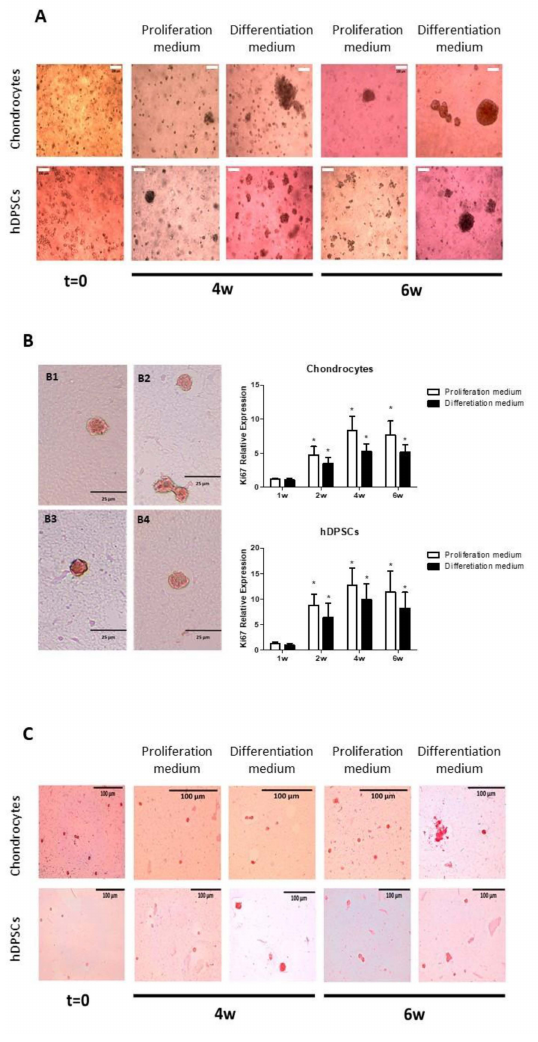
Figure 4. Encapsulation of cultured cells in alginate-agarose hydrogels. Human primary chondro- cytes or hDPSCs were cultured in hydrogels containing 3% alginate and 1% agarose with proliferation or differentiation medium, for up to 6 weeks at a density of 2 × 10 6 cells/mL. ( A ) Cell distribution was evaluated by phase contrast microscopy. ( B ) Cell proliferation was estimated by ki67 expression detected by immunohistochemistry (panels B1-4) and determined by real-time RT-PCR. Ki67-positive chondrocytes are shown in subpanel B1 (in proliferation medium), B2 (in differentiation medium), and ki67-positive hDPSC in B3 (in proliferation medium) and B4 (in differentiation medium), all cultured for 6 weeks. Graphs represent the expression of the Ki67 gene; data represent means ± SD of n = 3, * p < 0.05 compared to cells cultured for 1 week. ( C ) Collagen synthesis was studied by Sirius red staining. Representative microscopic images from three independent experiments are shown. Scale bars equal to100 µ m ( A , C ) or 25 µ m ( B